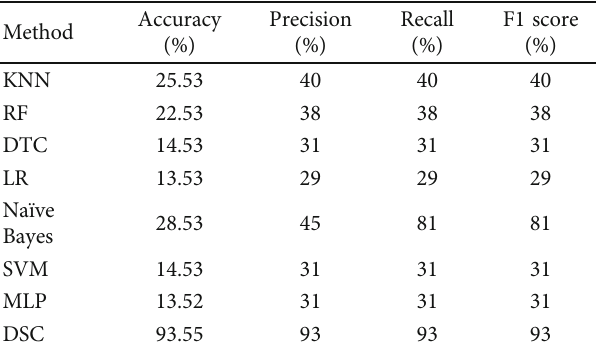
Table 10: DSC method obtained an average